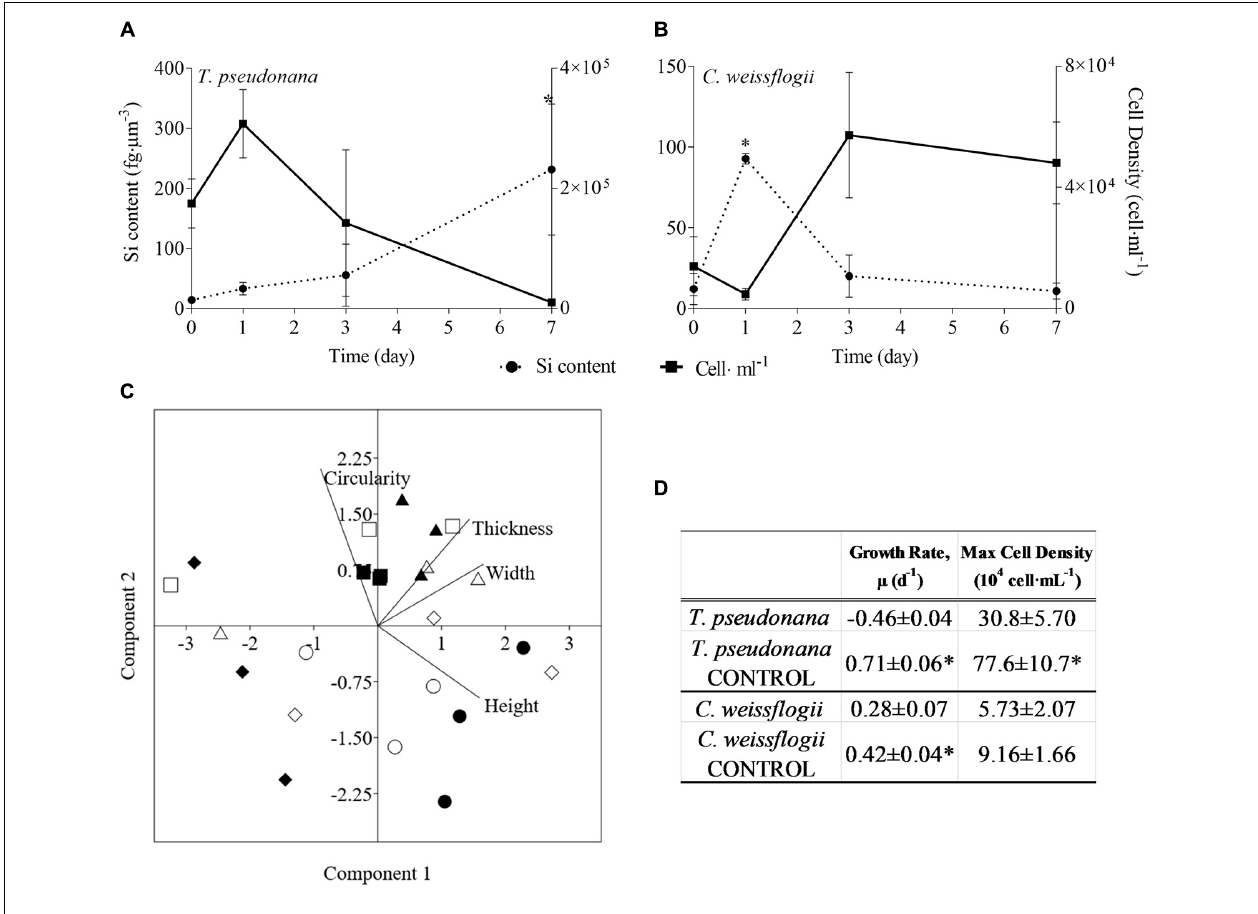
FIGURE 1 | (A,B) Si content (fg µ m − 3 ; dashed line) and cell density (cell ml − 1 ; solid line) in the two centric diatom species under copepods exposure. Data are means of 3 biological replicas. Error bars show SD while asterisks indicate significant differences in Si content of each species among days according to one-way ANOVA followed by Tukey’s post-hoc test, p < 0.05 (details in Supplementary Table 11 ). (C) PCA analysis on morphological characteristics of centric diatoms ( T. pseudonana and C. weissflogii ) in monospecifc cultures. Different symbols indicate different time points during the experiment: T0 ◦• ; T1 (cid:3)(cid:4) , T3 (cid:52) (cid:78) , T7 ♦(cid:7) , while different colours indicate different species: black for T. pseudonana white for C. weissflogii . (D) Comparison of growth rates (d − 1 ) and maximum cell densities (cells · mL − 1 ) for each of the two diatom species between cultures with and without (CONTROL) copepods. The values are means of 3 biological replicas ± SD. For each species, asterisks indicate when growth rate or max cell density were statistically different between diatoms exposed or not (CONTROL) to copepods, unpaired t test, p < 0.05 ( Supplementary Table 11